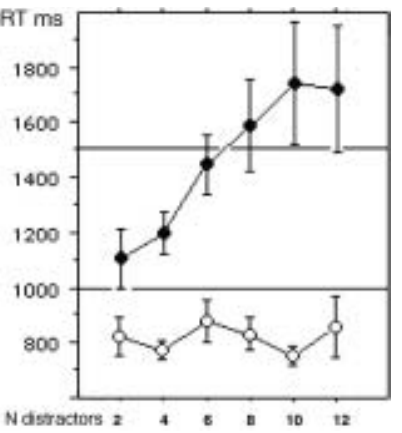
Fig. 5. Decision as to the presence or absence of an odd item within a set of several scrambled discs, on the basis of one parameter (green vs red) or two parameters (small or big, red or green). For one-parameter displays AT’s response times remained stable despite theaddition ofdistractors (open circles). Fortwoparameters displays response times were longer and increased linearly with the addition of distractors (solid